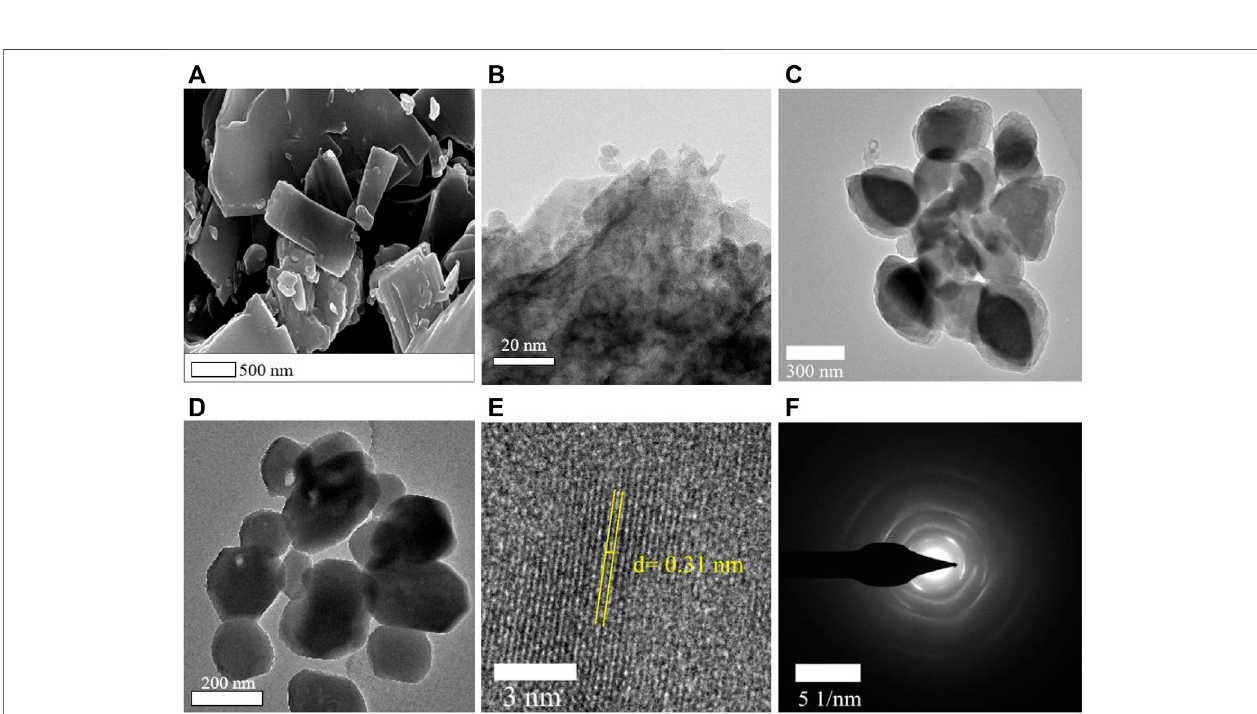
FIGURE 6 | (A) SEM of 1 and (B – F) TEM of nanosheets.